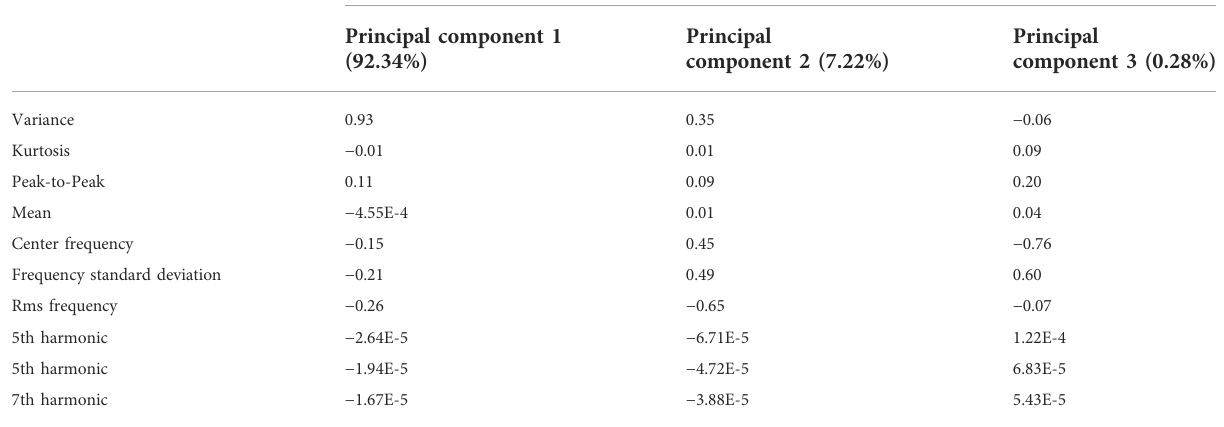
TABLE 4 Feature vector